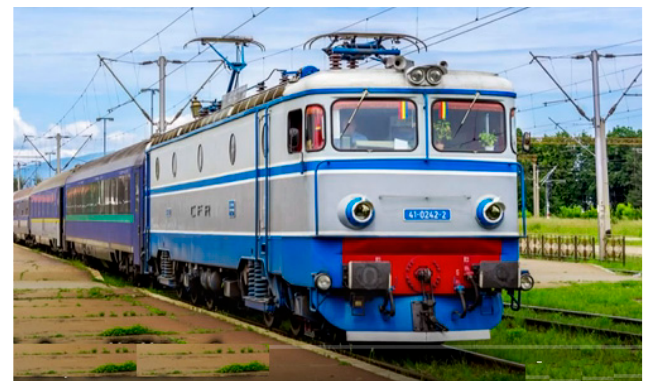
Figure 1. Electrical